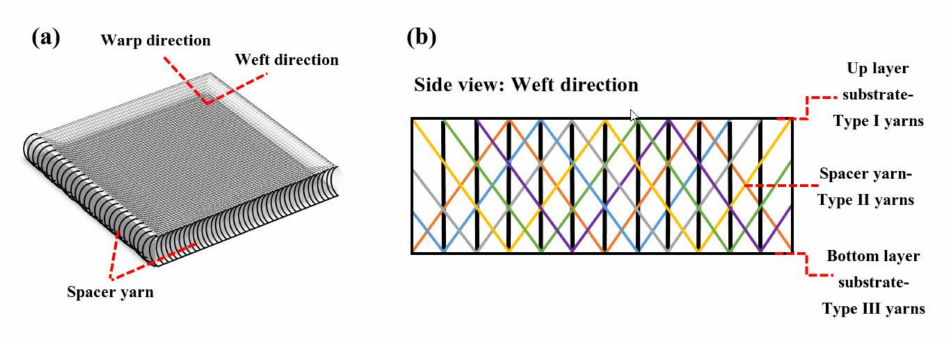
Figure 1. Schematic of 3D spacer fabric ( a ) global view, and ( b ) side